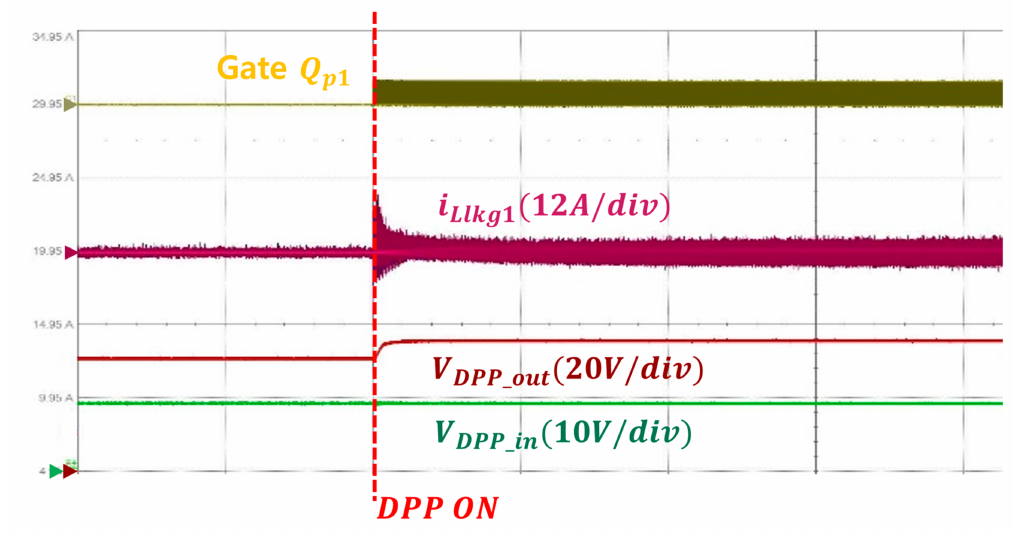
Figure 15. Experimental key waveform of the DPP converter at the soft-start-up